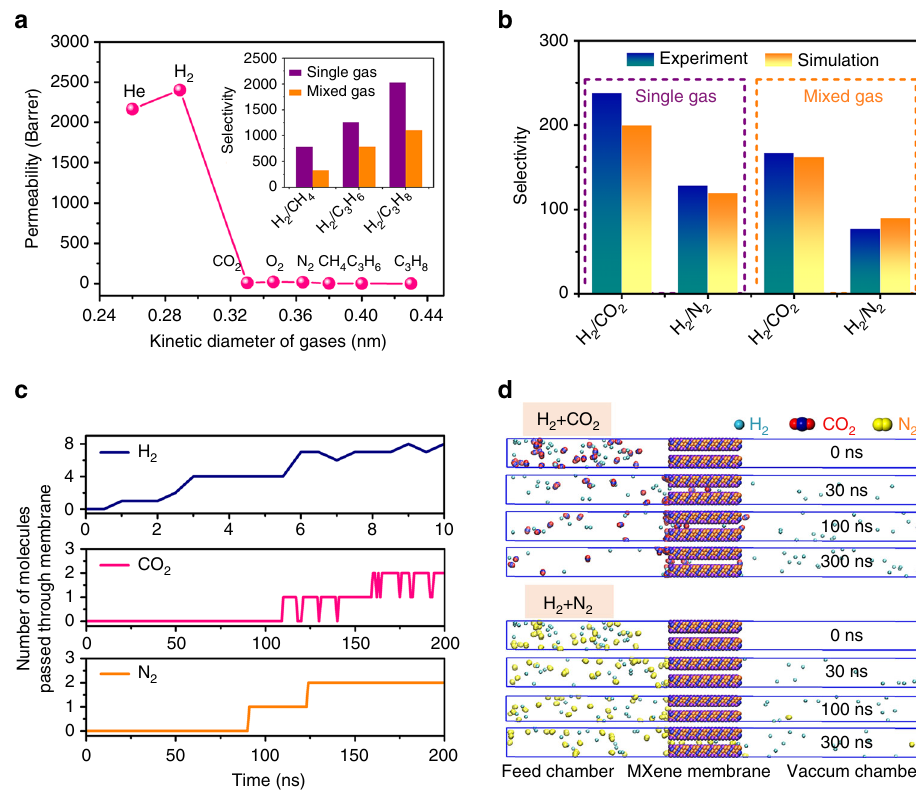
Fig. 2 MD simulations of the gas permeation through the MXene membrane compared with the experimental results. a Single-gas permeabilities through a 2- μ m-thick MXene membrane as a function of the gas kinetic diameter at 25 °C and 1 bar. Inset shows the selectivity of H 2 relative to the other gases in both the single-gas and equimolar mixed-gas permeation studies. b Comparison of the experimental and MD simulated selectivities of H 2 /CO 2 and H 2 /N 2 in both the single-gas and mixed-gas permeations. c The number of gas molecules that passed through the MXene membrane in MD simulation as a function of simulation time for single-gas permeation. For H 2 , only the fi rst 10 ns of the simulation are shown because of its fast permeation. By contrast, only two molecules pass through the MXene membrane during the 200-ns-long simulation for CO 2 or N 2 . The CO 2 curve fl uctuates because of CO 2 adsorption – desorption on the MXene membrane. d Simulation snapshots at 0, 30, 100, and 300 ns for two sets of mixed-gas permeation systems: (H 2 + CO 2 ) and (H 2 + N 2 ). Note that H 2 was modeled by united-atom force fi eld. The MXene membrane was composed of two nanosheets with a free spacing of 0.35 nm located in the middle of the simulation system. In the beginning ( t = 0 ns), 30 H 2 and 30 CO 2 (or N 2 ) molecules were present in the feed chamber, which permeated through the MXene membrane to the evacuated permeate chamber. The details can be found in section of “ Methods feed to permeate chamber are 0.75, 0.0038, 0.0071, and 0.0063 − 1 molecule ns , respectively (each value are estimated from the average of four 200-ns-long MD simulations, except for the H 2 fl ux) (Supplementary Table 5). The simulated selectivities of H 2 / CO 2 (200) and H 2 /N 2 (120) are comparable to their respective experimental values of 238 and 129 (Fig. 2b). From the mixed-gas separation simulations (Fig. 2d), the selectivities of H 2 /CO 2 (162)